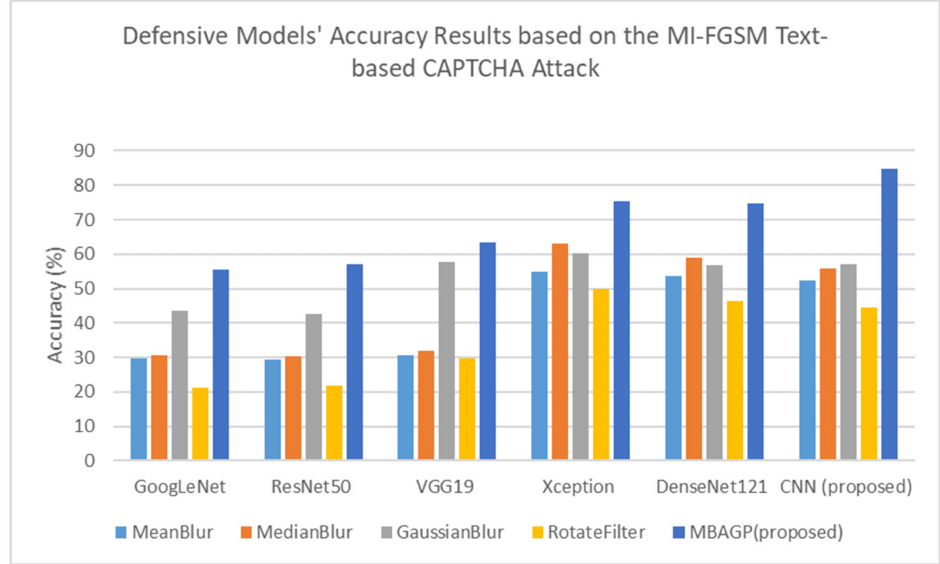
Figure 21. Comparison results of the testing accuracies obtained by the defense models, based on the MI-FGSM text-based CAPTCHA attack, in terms of the proposed MBAGP-CNN model.